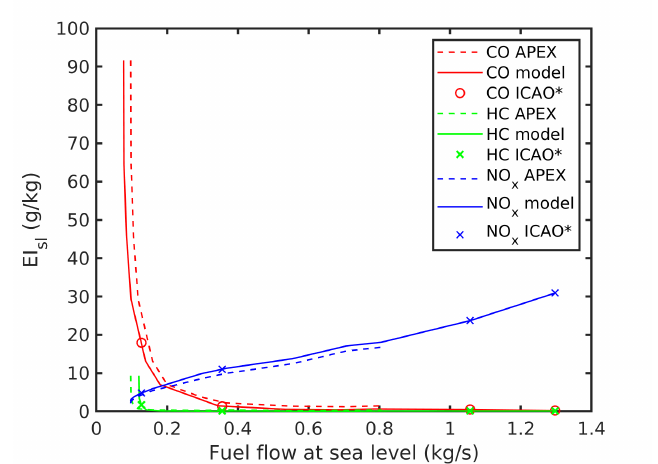
Figure 2. Modeling of emissions indices at sea level for the CFM56-7B27 engine based on the ICAO emissions data points adjusted for installation effects (*), and the APEX data for a similar engine